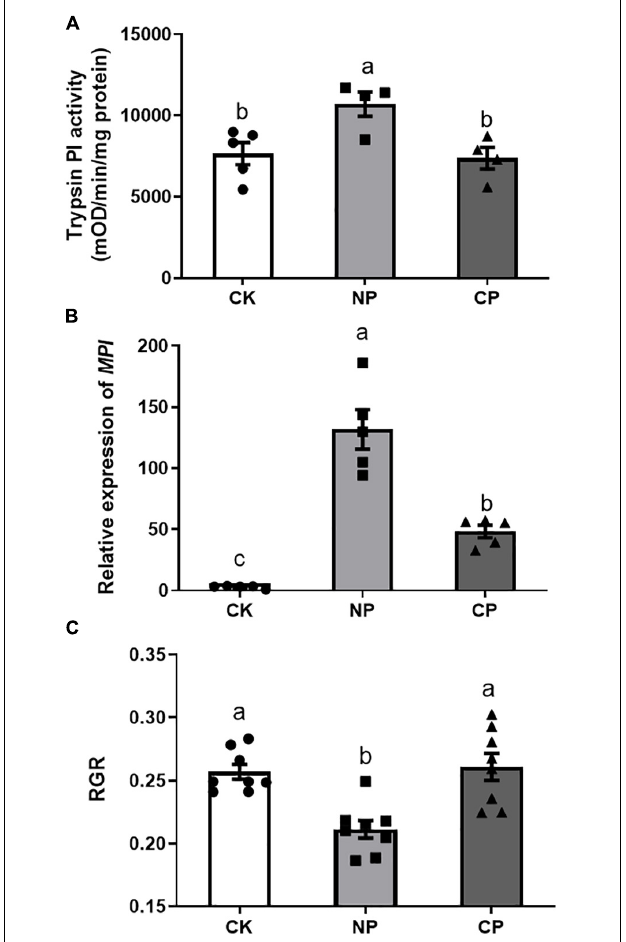
FIGURE 4 | Effect of fall armyworm larvae with parasitism on inducing defense responses in maize. (A) Trypsin proteinase inhibitor (Trypsin PI) activity in maize plants ( F 2 , 12 = 6.703, p = 0.014; n = 5, Fisher’s test). (B) Maize proteinase inhibitor ( MPI ) gene expression in maize plants ( F 2 , 12 = 44.64, p < 0.001; n = 5, Fisher’s test). (C) Relative growth rate (RGR) of parasitized caterpillars feeding on plants previously treated with parasitized caterpillars ( F 2 , 21 = 11.52, p = 0.0004; n = 8, Fisher’s test). Values are untransformed mean ± SEM. Different letters indicate significant differences between treatments. CK, undamaged plants; NP, maize plants damaged by non-parasitized caterpillars; CP, maize plants damaged by